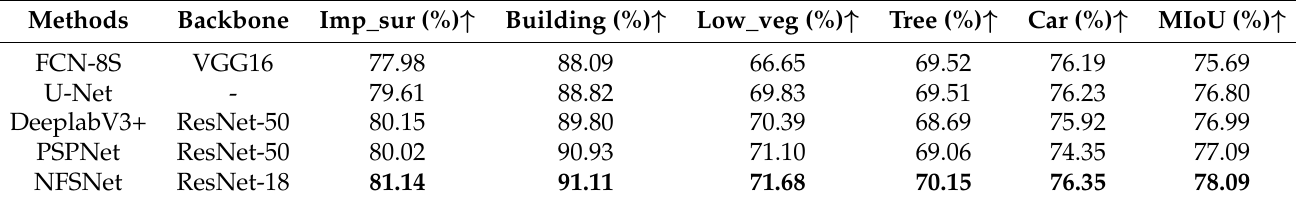
Table 4. Potsdam-B test set category IoU results. The highest values for the different metrics are highlighted in bold, ↑ means the higher the